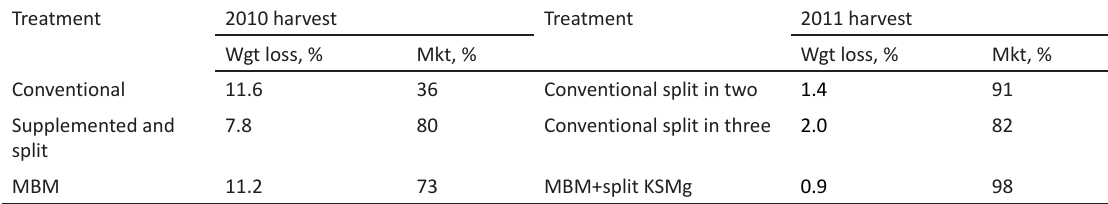
Table 12. Post-harvest loss of weight (Wgt loss) of carrots during storage from 5 Oct 2010 to 21 March 2011 (2010 field trial harvest) and from 12 Oct 2011 to 20 April 2012 (2011 field trial harvest), and marketable share (Mkt) of the quantity after the storage